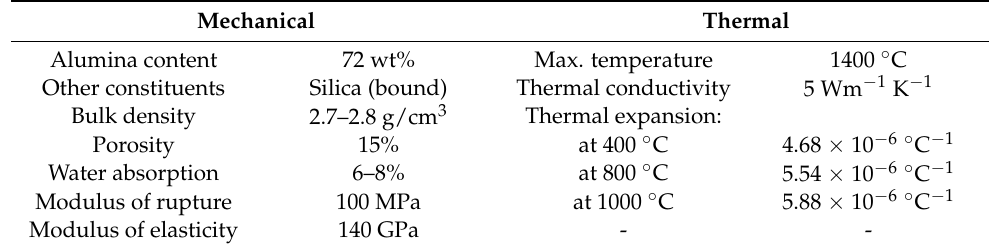
Table 3. Thermo-mechanical properties of mullite supplied by Ceradvance Engineering Ceramics. Mechanical